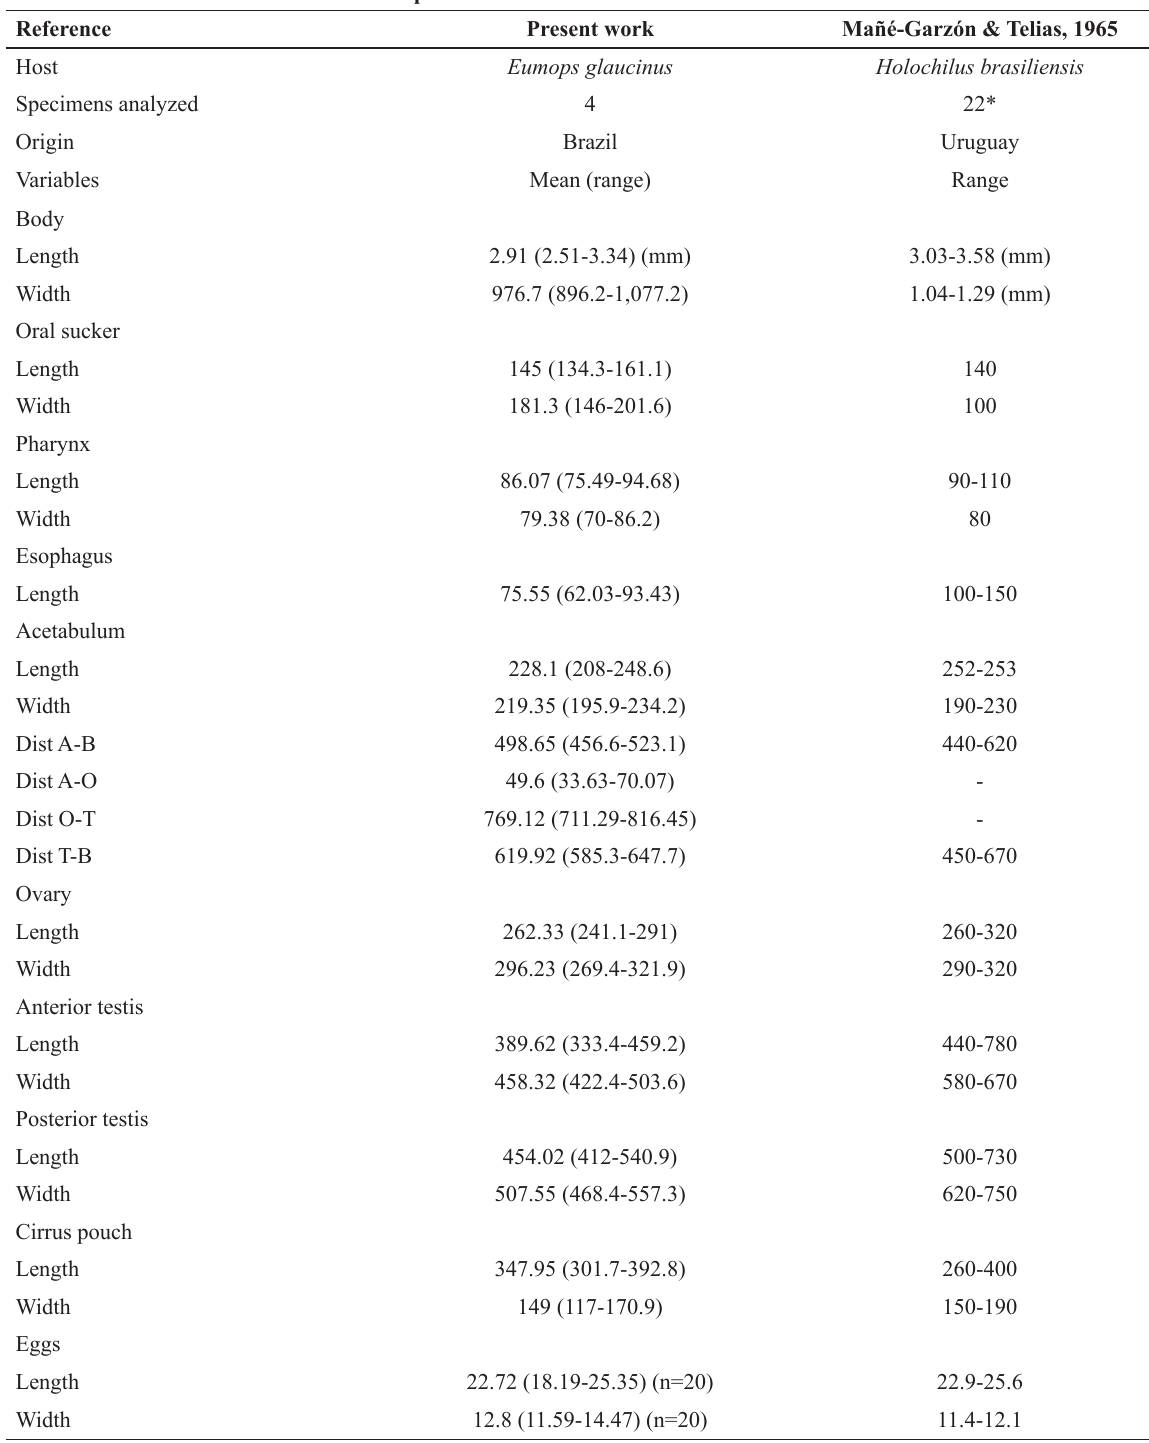
Morphometrical data of Urotrema macrotestis